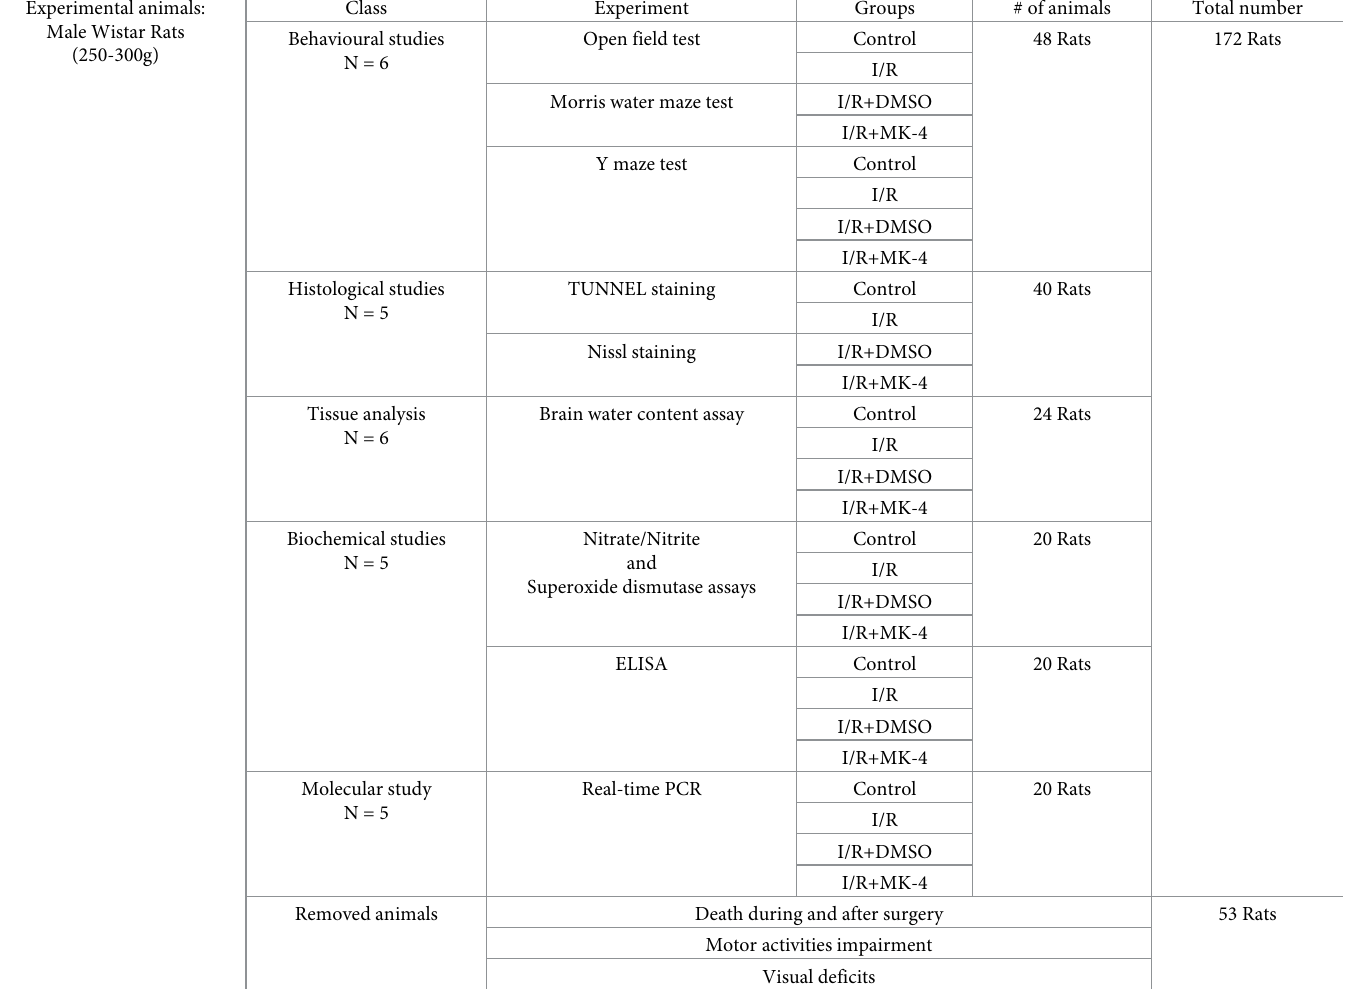
Table 1. Number of total animals that used in the experimental groups and removed from the study. Experimental animals: Male Wistar Rats